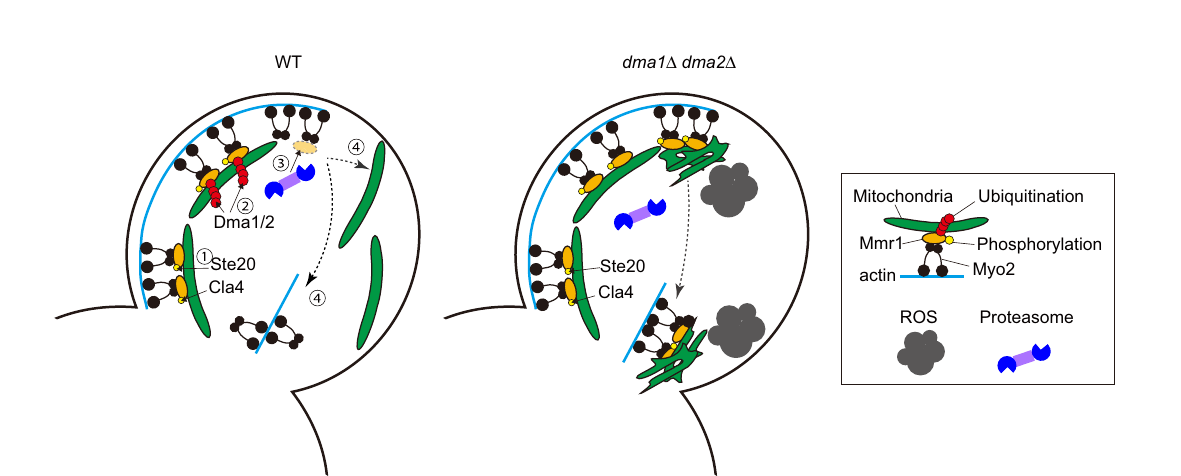
Fig. 8 dma1 Δ dma2 Δ cells produce more ROS. a W303-1a (WT) and YTK5416 ( dma1 Δ dma2 Δ ) cells in log phase were loaded with 5 µ M CellROX Green reagent for 1 h, and observed by fl uorescence microscopy. m and d, mother and daughter cells, respectively. Arrowhead, CellROX Green reagent signal from stacked mitochondria. Bar, 5 µ m. b Intensity of CellROX Green reagent signal. Imaging data from ( a ) were used. The box covers the region from the 1st quartile to the 3rd quartile. The horizontal line and cross mark represent the median and the mean, respectively. The whiskers at either side of the box extend to 1.5 interquartile ranges from the quartiles. For glucose-containing medium, 224 and 267 cells for WT and dma1 Δ dma2 Δ , respectively, were analyzed. For glycerol-containing medium, 180 and 261 cells for WT and dma1 Δ dma2 Δ , respectively, were analyzed. Signi fi cance was tested by Mann – Whitney ’ s U test. Similar results were obtained from two independent experiments. c W303-1a (WT), YTK5416 ( dma1 Δ dma2 Δ ), and YOK5468 ( sod1 Δ sod2 Δ ) cells were grown to log phase; the cell density of each suspension culture was adjusted to A 600 = 0.5, serially diluted to 1:10, and spotted on YPD with or without 1 mM paraquat. d W303-1a (WT) and YTK5416 ( dma1 Δ dma2 Δ ) cells in log phase were treated with 10% ethanol (EtOH) or mock- treated for 2 h, stained with 8 µ g/mL phloxine B for 5 min, and observed. Bar, 5 µ m. e Proportions of dead cells were calculated using imaging data from ( d ). Values represent the means ± SDs from three independent experiments. Signi fi cance was tested by one-way analysis of variance with Tukey ’ s comparison (values of con fi dence intervals, degrees of freedom, and F are indicated). f W303-1a (WT), YTK5416 ( dma1 Δ dma2 Δ ), YOK5468 ( sod1 Δ sod2 Δ ), and YOK5481 ( dma1 Δ dma2 Δ sod1 Δ sod2 Δ ) cells were treated as in ( c ) and spotted on YPD medium. g W303-1a (WT), YTK5416 ( dma1 Δ dma2 Δ ), YOK5464 ( sod1 Δ ), YOK5466 ( sod2 Δ ), YOK5479 ( dma1 Δ dma2 Δ sod1 Δ ), and YOK5480 ( dma1 Δ dma2 Δ sod2 Δ ) cells were treated as in ( c ) and spotted on YPD